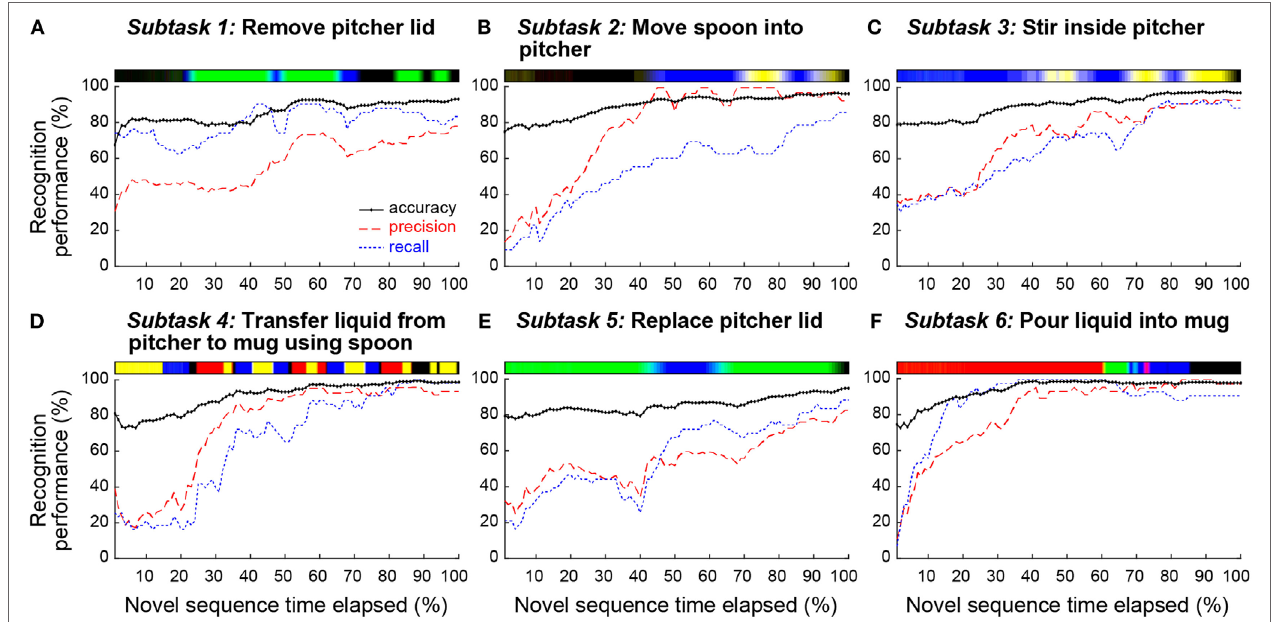
FigUre 9 | Using a leave-one-out approach, the performance of the action recognition algorithm is reported as a function of the elapsed time of a novel gaze object sequence for each subtask. Accuracy (black solid line), precision (red dashed line), and recall (blue dotted line) are shown for each of the six subtasks (a–F) . The characteristic gaze object sequence is shown above each subplot. The colors in the sequence correspond to the objects shown in Figure 1c .